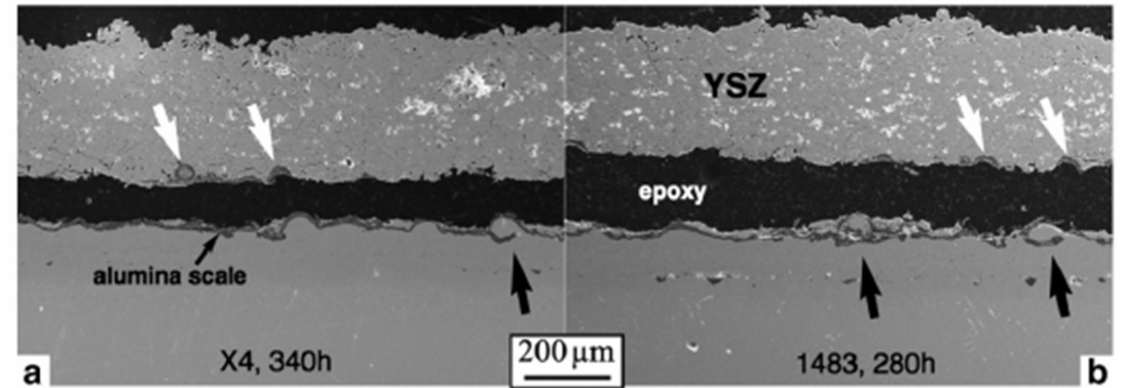
Figure 5. Scanning electron microscope (SEM) images comparing the topcoat delamination during 1-h thermal cycles at 1100 ◦ C in 10 vol.% water vapour. ( a ) TBC on X4 bond coat after 340 cycles, ( b ) TBC on 1483 bond coat after 280 cycles. White arrows indicate alumina undercutting the yttria-stabilized-zirconia (YSZ)